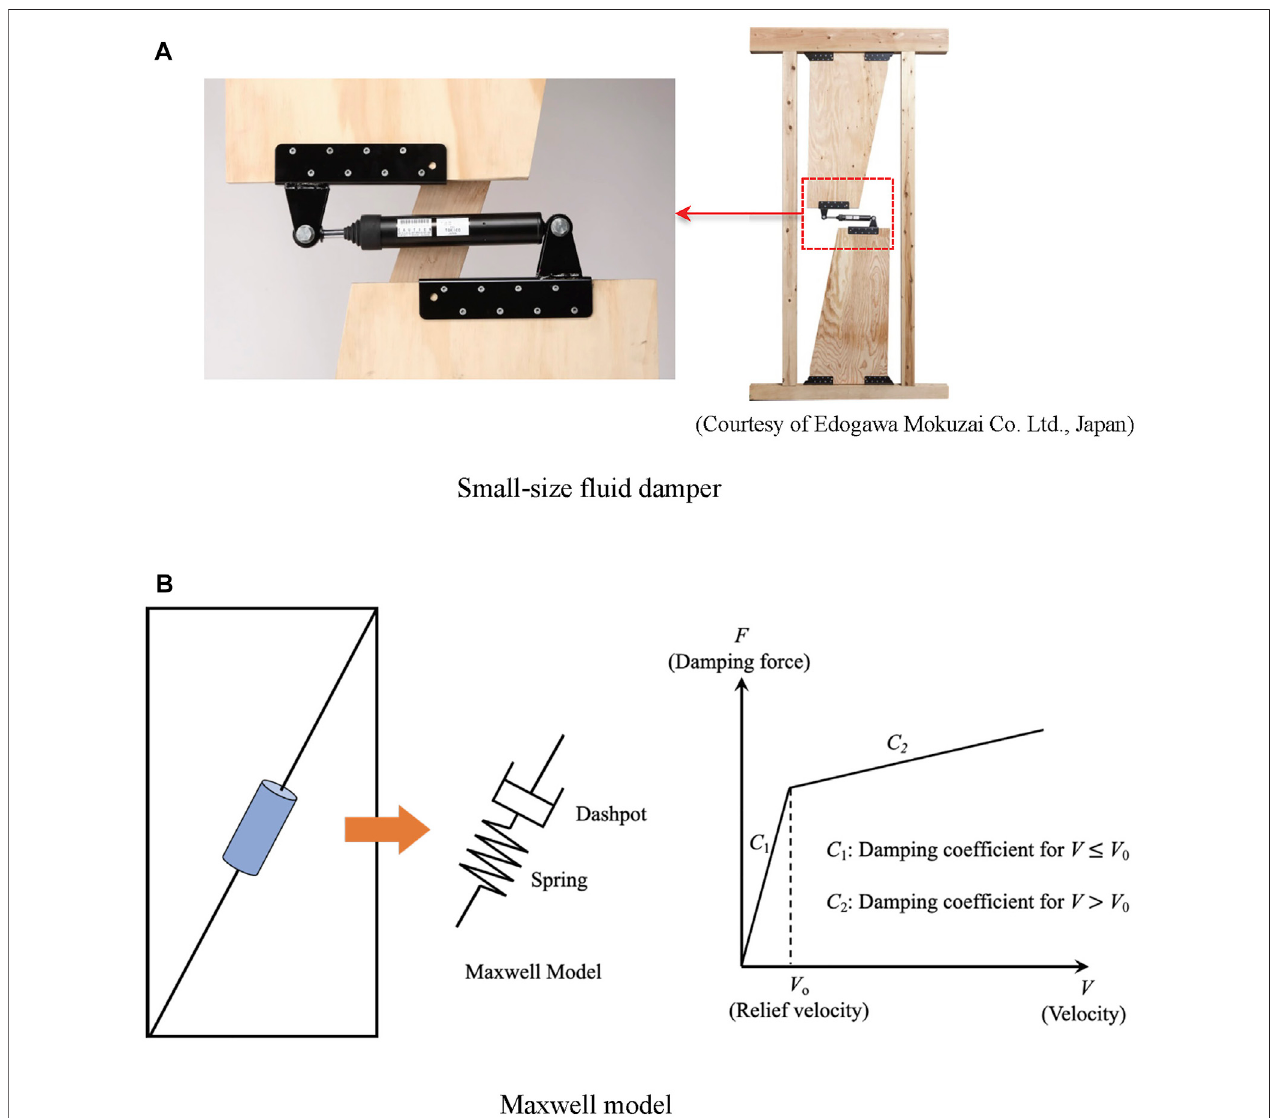
FIGURE 2 | Small-size fl uid damper for timber frame houses. (A) Small-size fl uid damper. (B) Maxwell model.